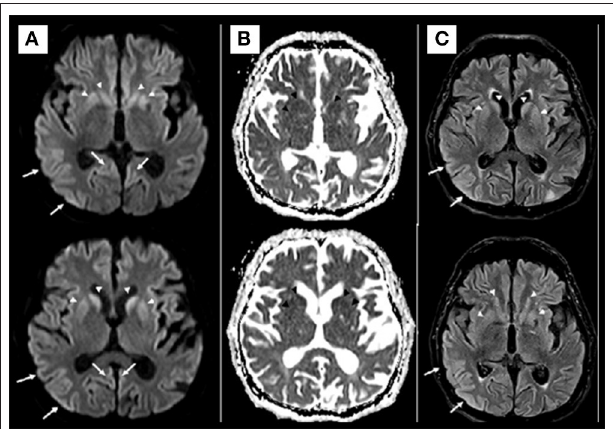
FIGURE 1 | Axial diffusion [diffusion weighted imaging (DWI)] (A) and apparent diffusion coefficient (ADC) map (B) MRI at admission. Diffusion restriction involving the cerebral cortex and basal ganglia (arrows in A ). No convincing white matter involvement. The hypotheses for MRI findings were pos-ictal state, hypoxic-ischemic encephalopathy, and spongiform encephalopathy. Axial Diffusion and FLAIR (C) MRI after 2 weeks demonstrated similar imaging findings, making the hypothesis of spongiform encephalopathy more